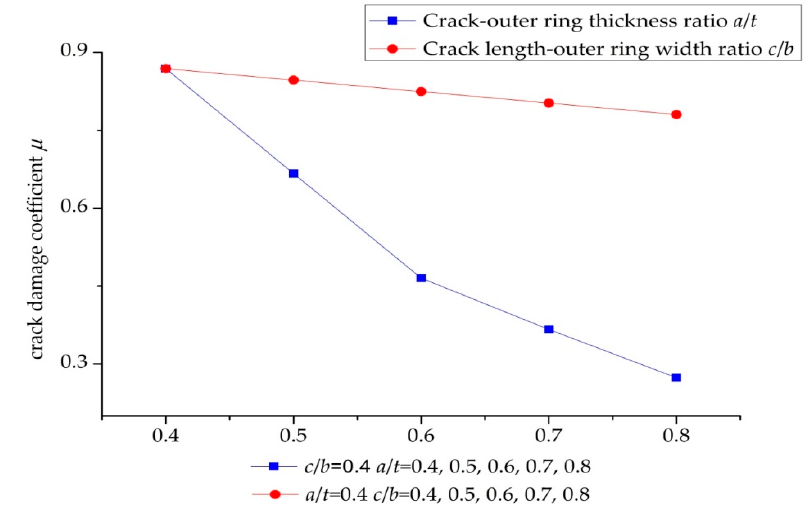
Figure 6. Comparison of the effects of another influencing factor on the crack damage coefficient μ when the crack–outer ring thickness ratio a / t or the crack length–outer ring width ratio c / b does not change.